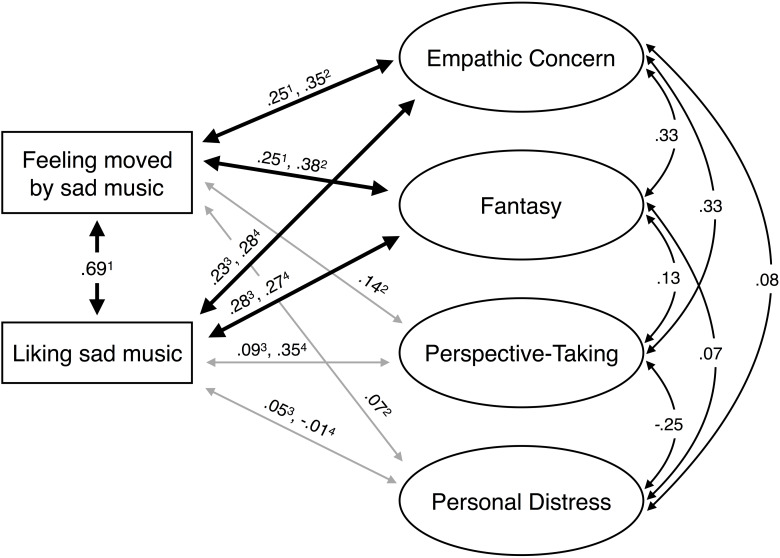
A visualization of the correlations between the subscales of the Interpersonal Reactivity Index (IRI) (a measure of trait empathy; Davis, 1980), liking for nominally sad music excerpts, and feelings of being moved evoked by nominally sad excerpts. Note that the generally low correlations are addressed in the “Discussion” section. The correlations between the trait empathy subscales (Empathic Concern, Fantasy, Perspective-Taking, and Fantasy) are taken from Davis (1983); (N = 1344, American undergraduates). The studies and sample sizes for the other correlations are listed below. 1Vuoskoski and Eerola (2017): N = 308, diverse nationalities. 2Eerola et al. (2016): N = 102, a representative sample of Finnish adults. 3Vuoskoski et al. (2012): N = 131, Finnish university students. 4Kawakami and Katahira (2015): N = 84, Japanese children (mean age: 11.9 years).